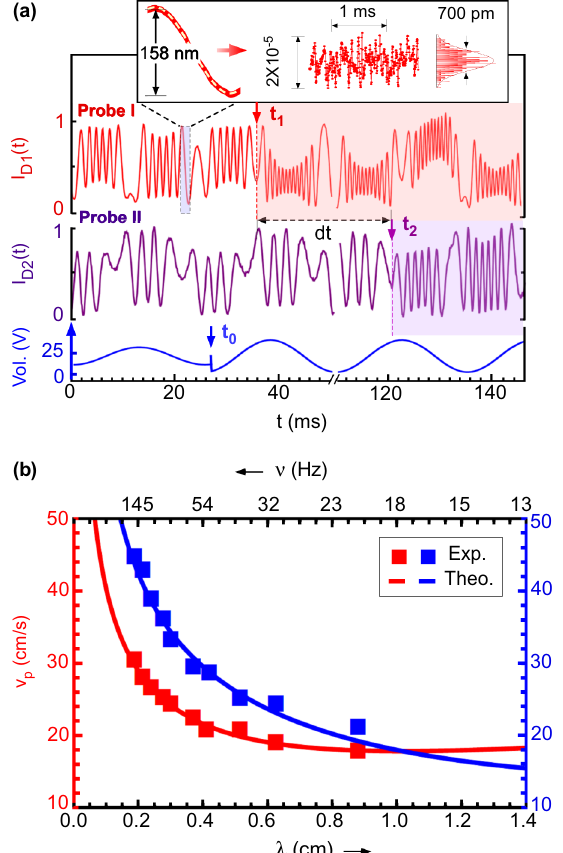
Figure 2. Propagation and dispersion of capillary waves on milk. ( a ) Central fringe intensities I D 1 and I D 2 of interferometric probes, separated by a distance ( (cid:31) x = 2 cm along with the periodic driving voltage at 40 Hz. Inset shows the precision of our interferometer in terms of the residual noise ∼ 700 pm . The residual noise is estimated after subtracting background oscillations over half-cycle (dotted yellow line). ( b ) Capillary wave velocities at different excitation frequencies for milk. Blue and red squares are the measured values and solid lines are the theoretical fits. Error bars are within the size of data